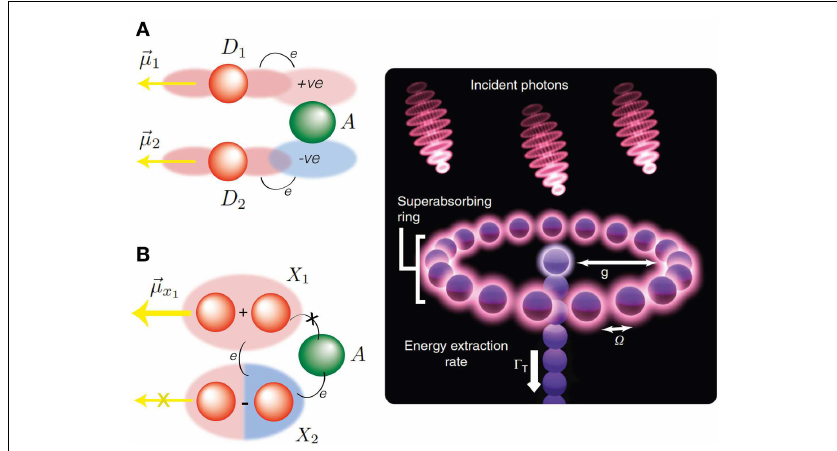
FIGURE 1 | Left panel : the photosynthetic reaction center modeled in Creatore et al. (2013), consisting of two donor molecules (red spheres) and one acceptor molecule (green sphere). In (A) , the donor D 1 and D 2 are identical and uncoupled and both able to absorb and re-emit light (see the dipole moments µ µ 1 and 2 ). In (B) , the dipolar excitonic coupling between D 1 and D 2 leads to new excitable donor states ( X 1 and X 2 ) resulting from the quantum superposition of the original donor states: X 1 is a bright state with optical dipole moment µ x , while X 2 is a dark state, which cannot absorb or emit photons. Under a 1 variety of realistic and experimentally realizable parameters, the presence of a dark state lowers the role of deleterious radiative recombination processes, while increases the efficiency of charge transfer at the acceptor A .This leads to an enhanced current and power generation at the RC, compared to the uncoupled/ classical scheme of (A) ; see Creatore et al. (2013) for details. Right panel : a collection of N dipoles arranged in a ring structure reminiscent of the photosynthetic light-harvesting complex LH1. By using environmental quantum control techniques, Higgins et al. (2014) have shown that it is possible to achieve a regime ( superabsorption ), in which the N dipoles absorb incident photons with a rate proportional to N 2 , this effect being the absorptive analog of quantum superradiance.This model could be relevant to applications to solar energy harvesting, where the excitation induced by the absorption of solar photons are efficiently transferred from the ring structure to a central core absorber and then to a center converting such excitations into stored energy; see Higgins et al. (2014) for details. [Copied with permission from the original paper: Nat. Commun. 5, Article number: 4705